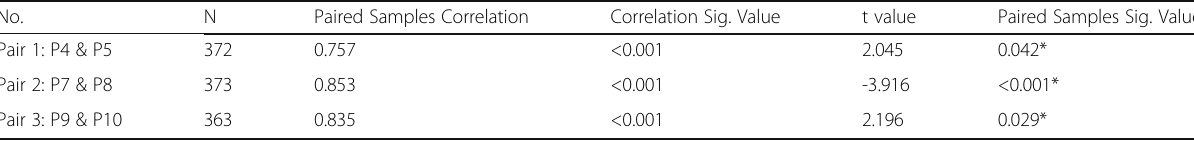
Table 6 Paired sample statistics for symmetry analysis of sacral morphometrics No. N Paired Samples